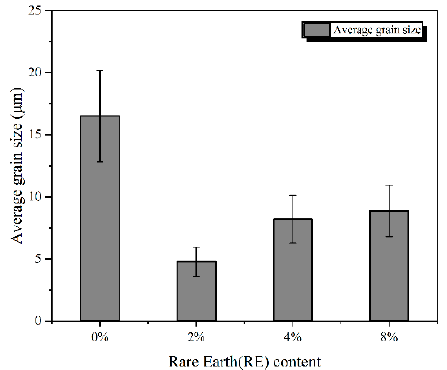
ff erent RE 2 FeB 2 hard phases with di